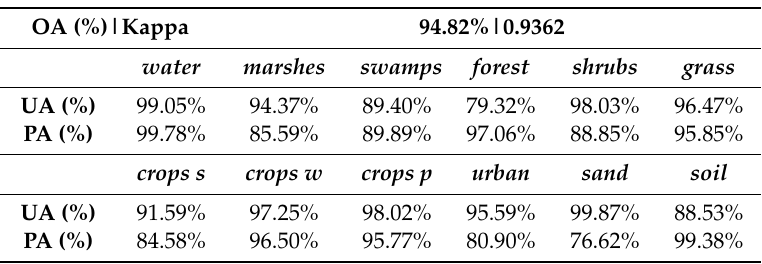
Table 7. Overall accuracy (OA) and kappa coefficient after the post-classification and User’s and Producer’s accuracies (UA and PA) for all the